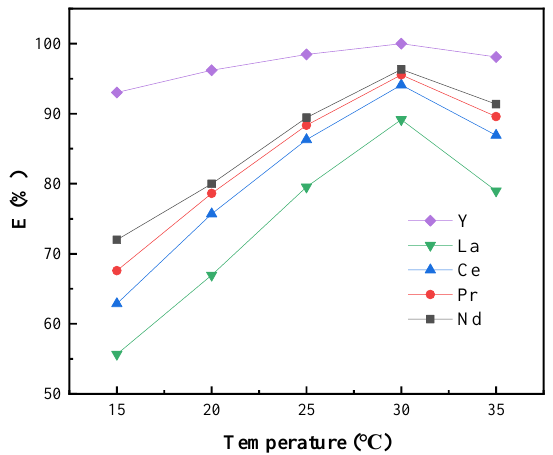
Figure 7. Effect of temperature on the extraction of REE.